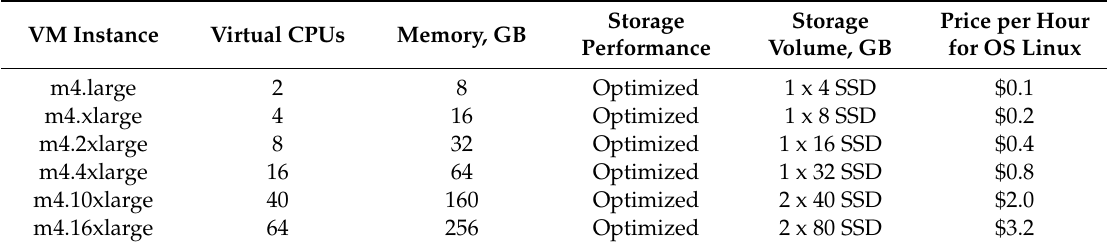
Table 4. Prices for AWS instances of the M4 type running operating system (OS) Linux / Unix in the US East region